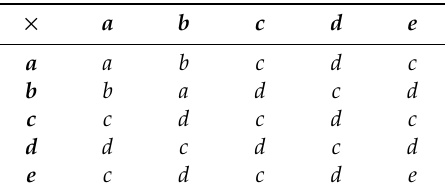
Table 15. The operation × on S